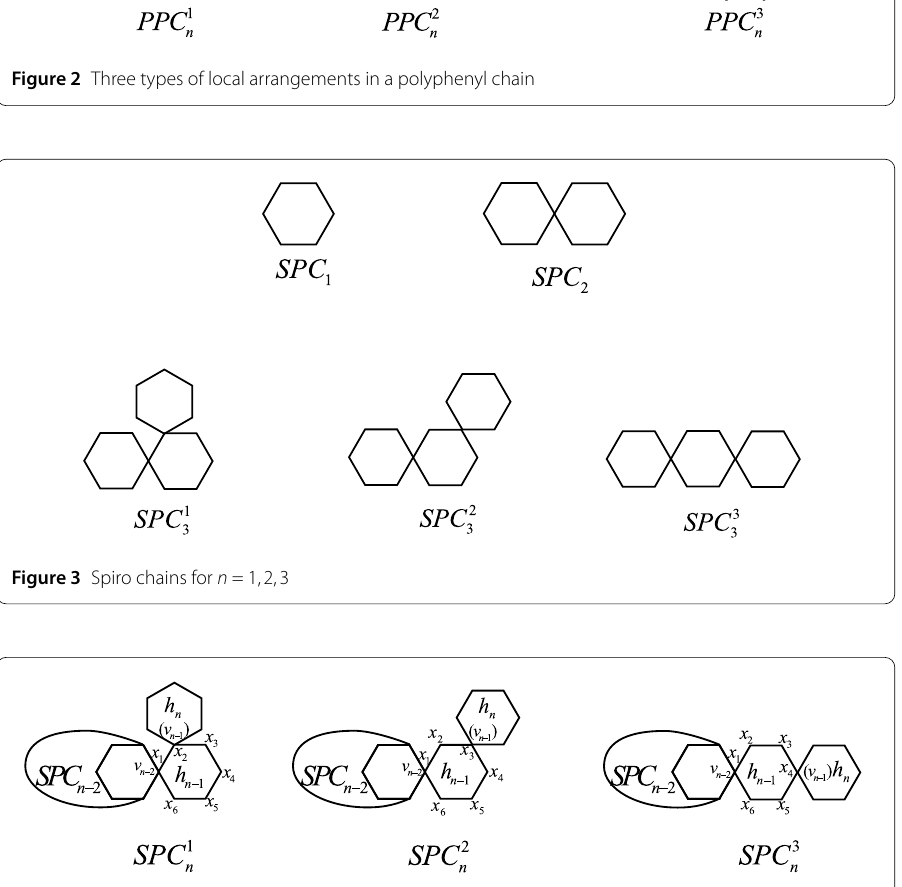
Figure 4 Three types of local arrangements in the spiro chain corresponding to a polyphenyl